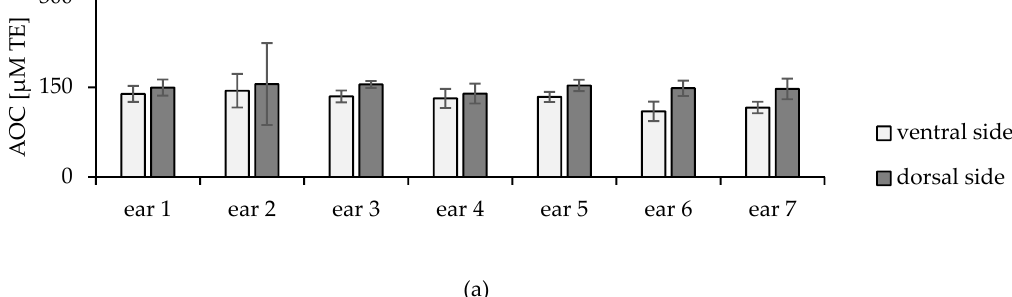
Figure 4. ( a ) iAOC (µM TE) and ( b ) average cumulative protein absorption (%) for dorsal and ven- tral sides of different ears, p = 0.0148 and 0.0016, respectively.